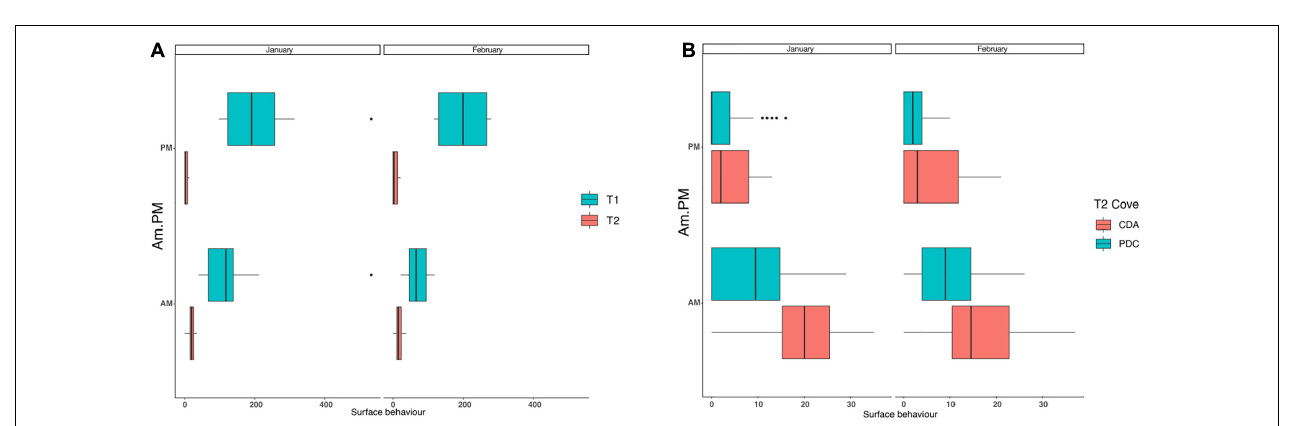
FIGURE 2 | Bottlenose dolphin group sizes in T1 (without whale watching) and T2 (with whale watching) in the study area. The horizontal line in the box represents the mean and the limits in the percentiles 25 and 75. The error bar indicates the maximum and minimum values.